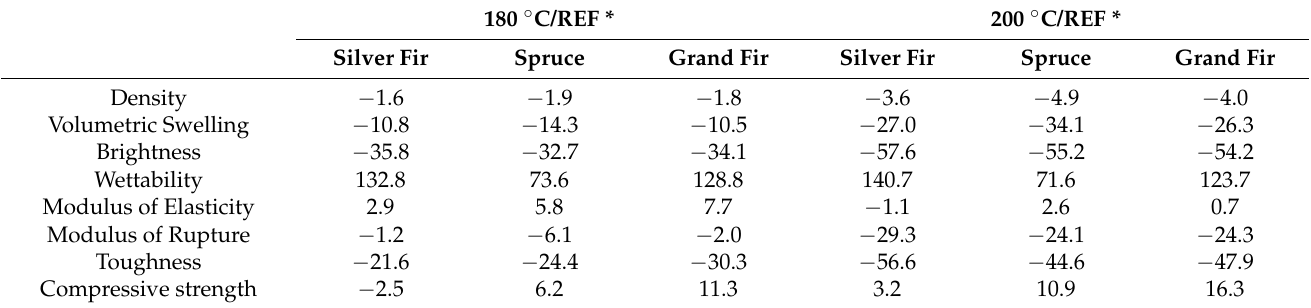
Table 2. Changes in properties (in %) for each species in relation to the degree of heat treatment. 180 ◦ C/REF